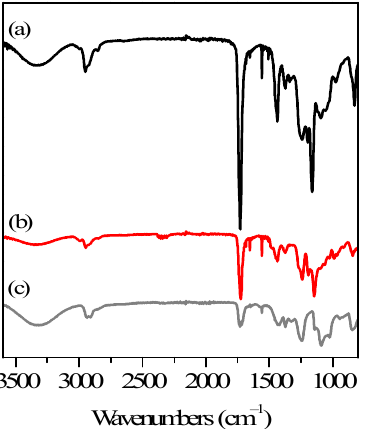
Figure 3. FTIR spectra of ( a ) CP1 and ( b ) CP5 as compared to original PVA ( c ).